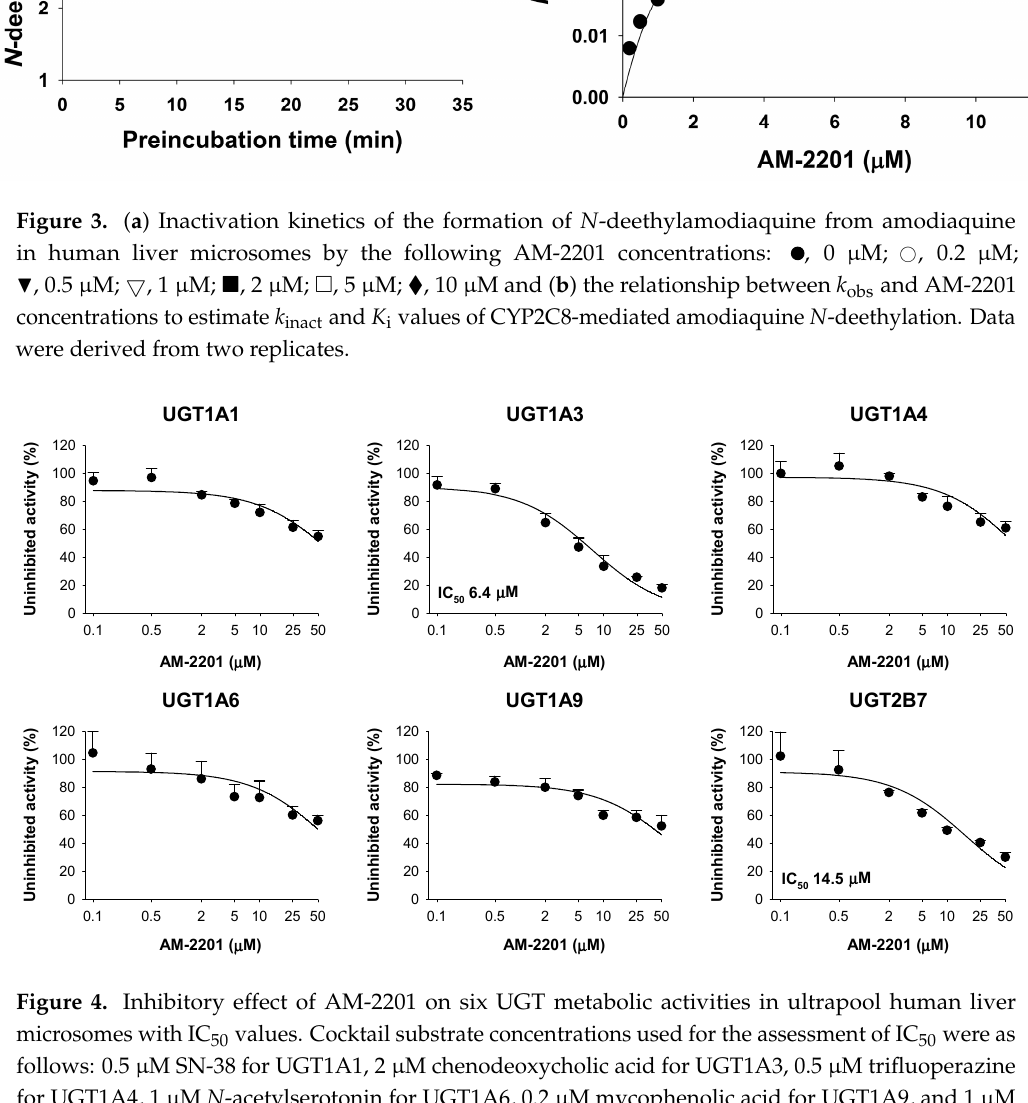
showed mixed inhibition of UGT2B7-catalyzed naloxone 3- β - D -glucuronidation, with a K i value of 10.0 μ M, in human liver microsomes (Figure 5).